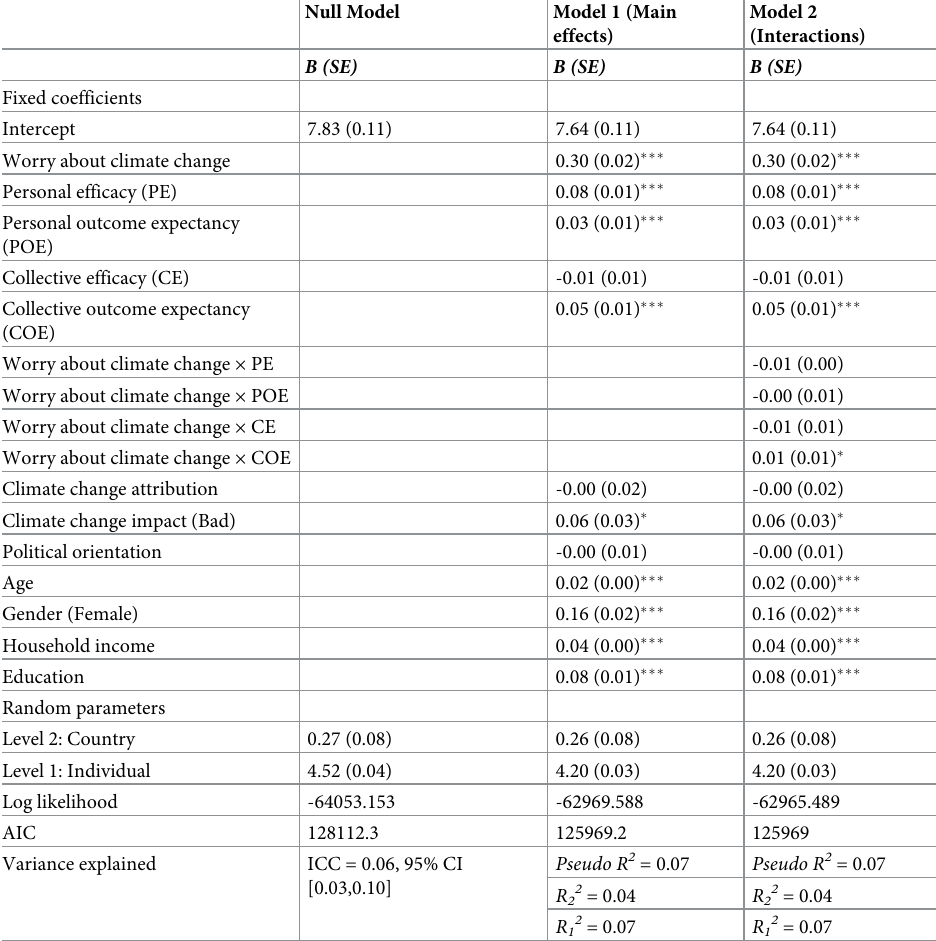
Table 4. Model results–Energy efficiency